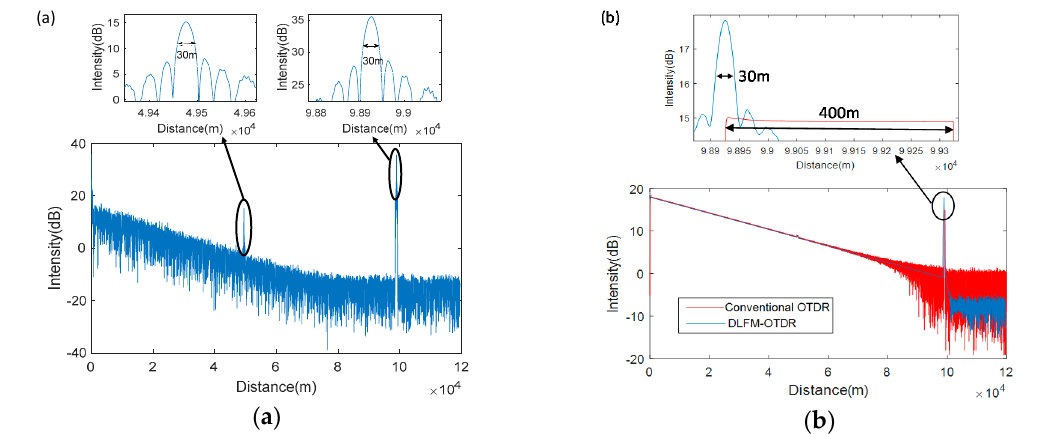
Figure 7. Measurement results of the rectangular short-time fractional Fourier transform window. ( a ) Considering only the primary linear frequency modulation signal in the backscattered signal. ( b ) The blue curve represents the results obtained when adding the direct current component, and the red curve the results of a conventional optical time domain reflectometry (OTDR) under the same experimental conditions.